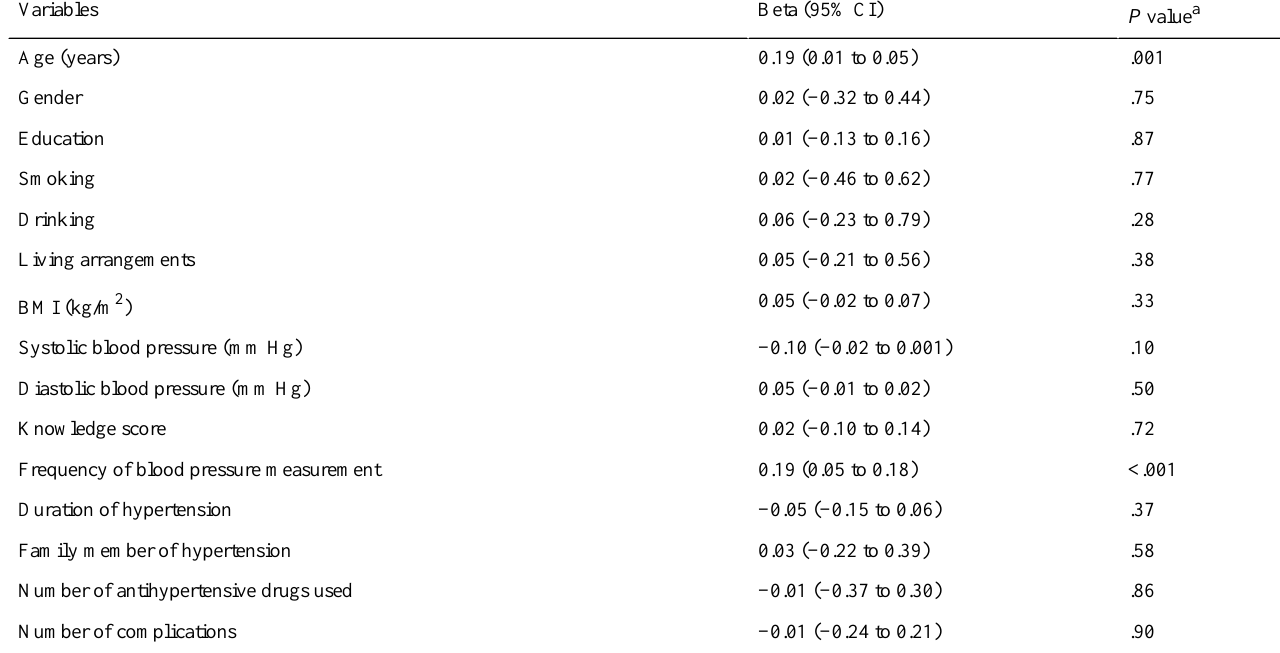
Table 3. Factors associated with medication adherence.